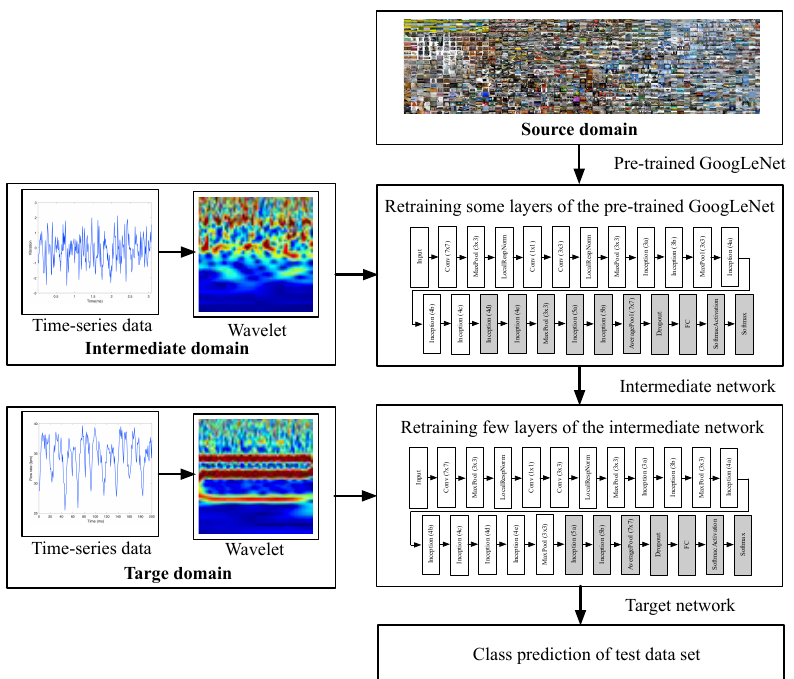
Figure 1. Proposed framework of fault diagnosis using limited target